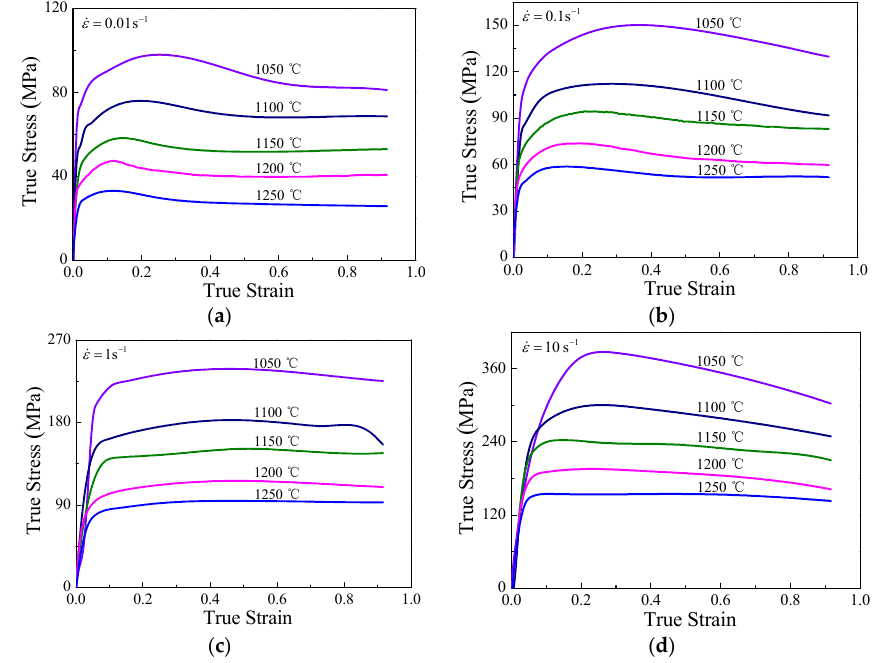
Figure 1. The true stress-strain curves of superalloy nimonic 80A under the different temperatures with strain rates ( a ) 0.01 s − 1 ; ( b ) 0.1 s − 1 ; ( c ) 1 s − 1 ; ( d ) 10 s − 1 .